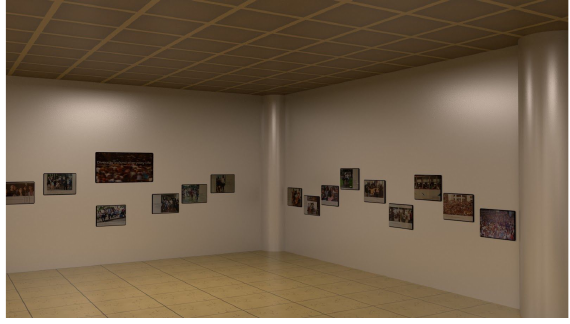
Figure 6. VR Environment showing the far end